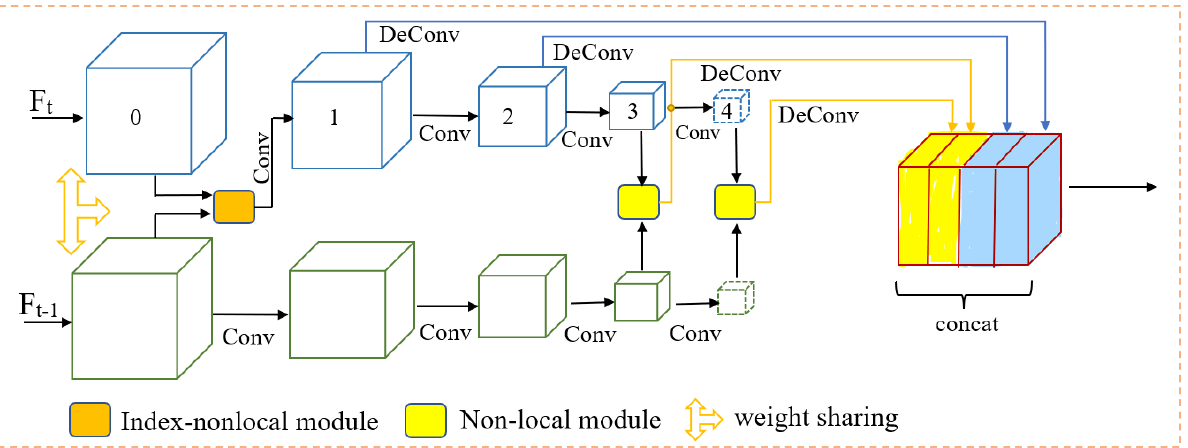
Figure 4. Feature extraction and fusion network. The 0th layer is the pseudo-image, which is generated by the point cloud